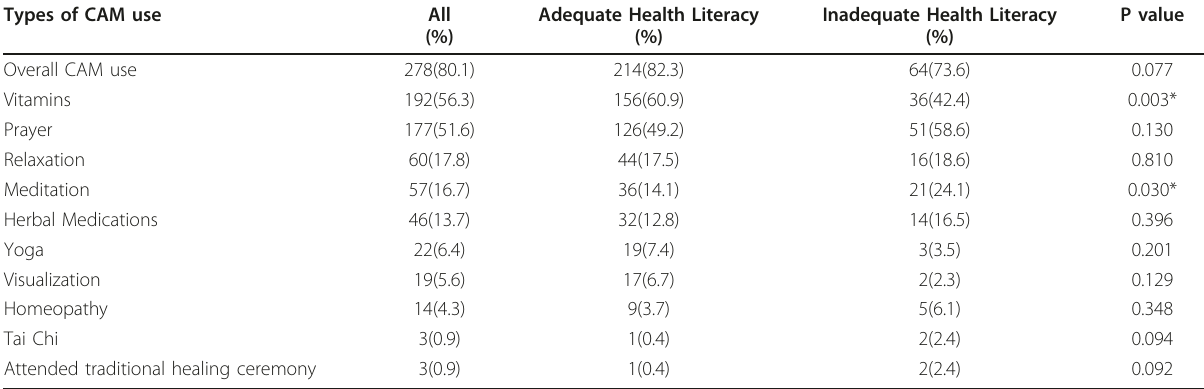
Table 2 Health Literacy and different types of CAM use Types of CAM use